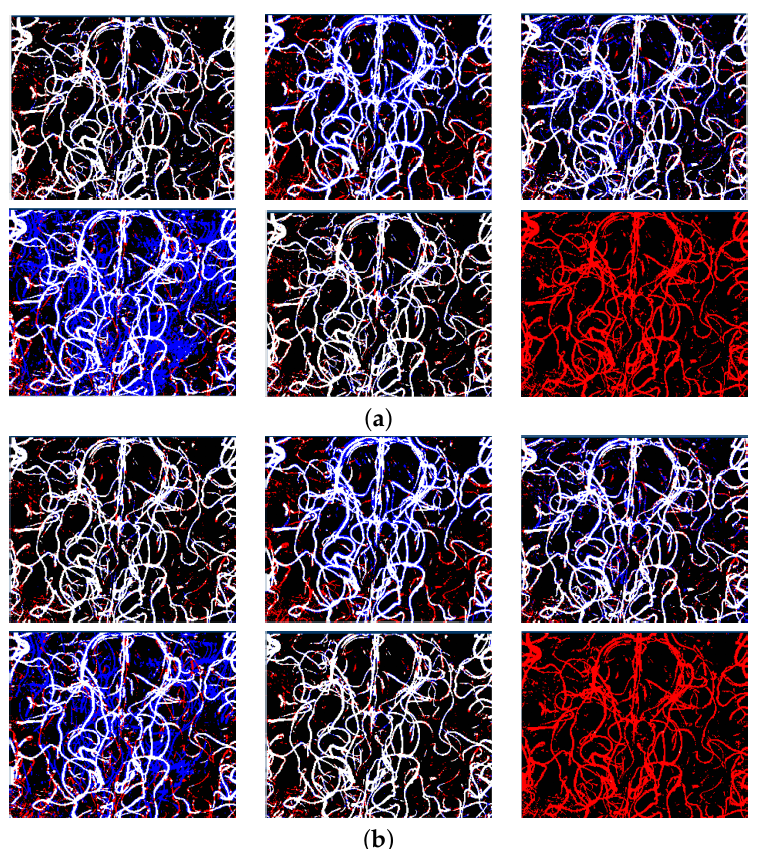
Figure A3. Performance of the models with deformation-aware learning, while dealing with various MR artefacts: (First row left to right) Random Bias Field, Random Blur, Elastic deformation (Second row left to right) Random Motion, Random Noise, and Random Spike. Red indicates false negative and blue indicates false positive while comparing against the dataset labels. ( a ) U-Net + deform. ( b ) U-Net MSS + deform.